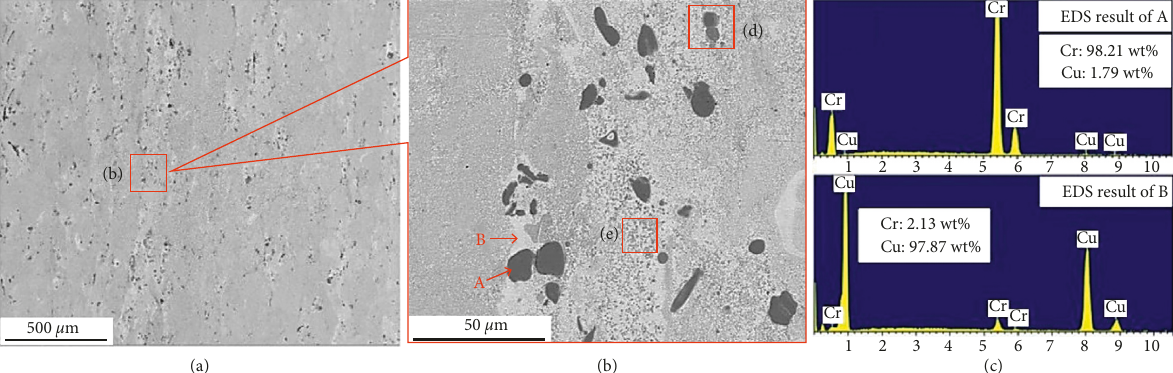
Figure 14: Microstructures of as-fabricated CuCr20. (a) The overall distribution of Cr in Cu. (b) Further magnification of (a), A indicates the Cr-rich phase with a particle size of ∼ 10mm, B indicates the Cu-rich phase surrounding A. (c) EDS results of A and B in (b)